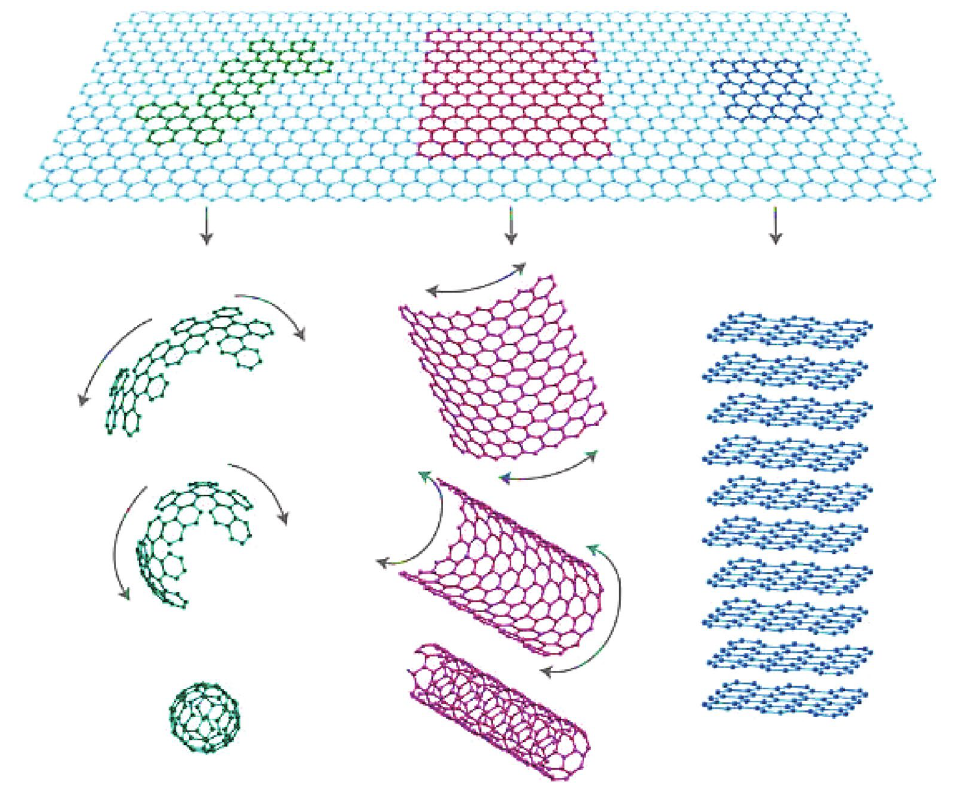
Fig. 3 Schematic representation of graphene as the mother of all graphitic family and fundamental basis of all carbon materials dimensionali- ties. Reproduced with permission from Ref. [69] Copyright © 2007, Springer